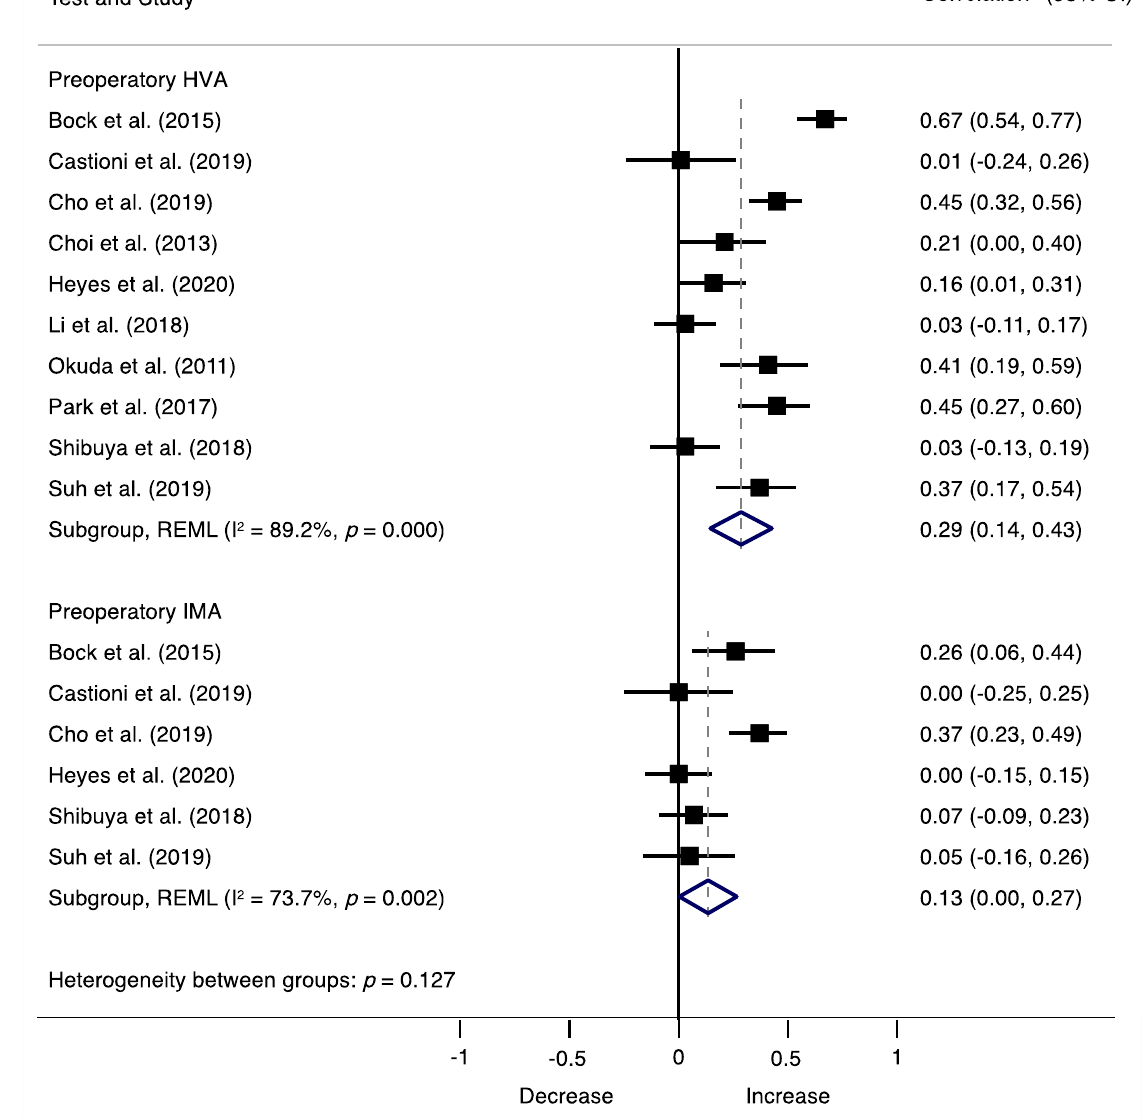
Figure 3. Forest plot showing the correlation of HV recurrence and preoperatory factors for each study. Squares represent pooled effect size for each subgroup analysis, and the diamond represents the overall pooled effect size. HVA, hallux valgus angle; IMA, intermetarsal angle.